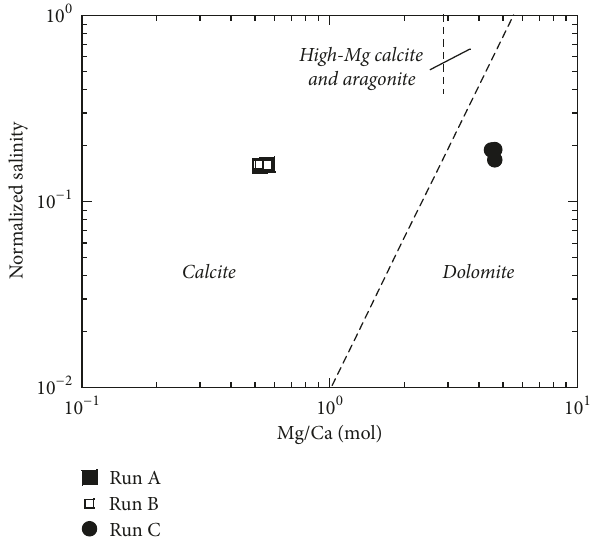
Figure 8: Stability field of calcite, aragonite, and dolomite. Phase boundaries are referred to by Matsuda